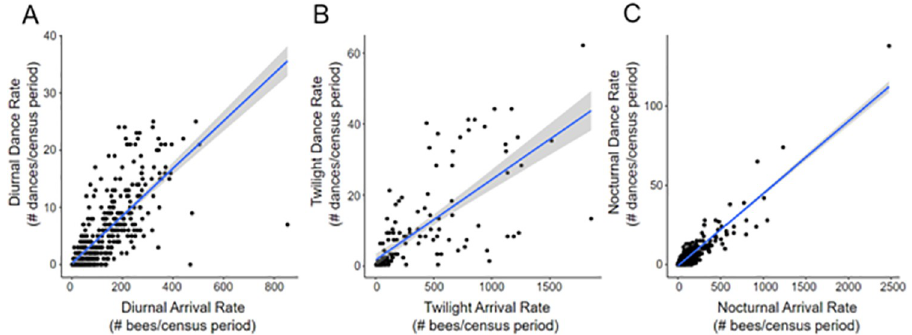
Fig 3. Relationship between bee arrival rates and dance rates. Regressions of number of bee arrivals against number of bee dances per census period are shown for (a) day time periods, (b) twilight time periods (both morning and evening), and (c) night time periods. Strong correlations were found between arrival and dance rates for all diel times ( r s > 0.82 for all). Data from all five A . dorsata colonies are included in this